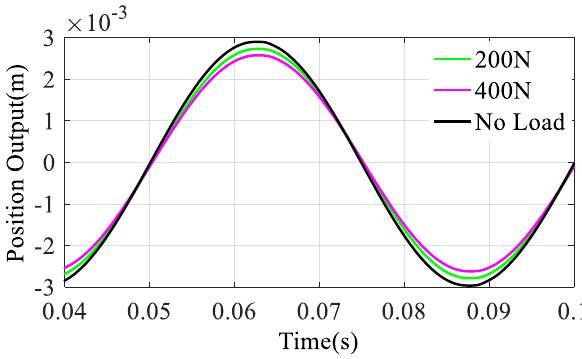
Figure 14. Position outputs under different damping loads.